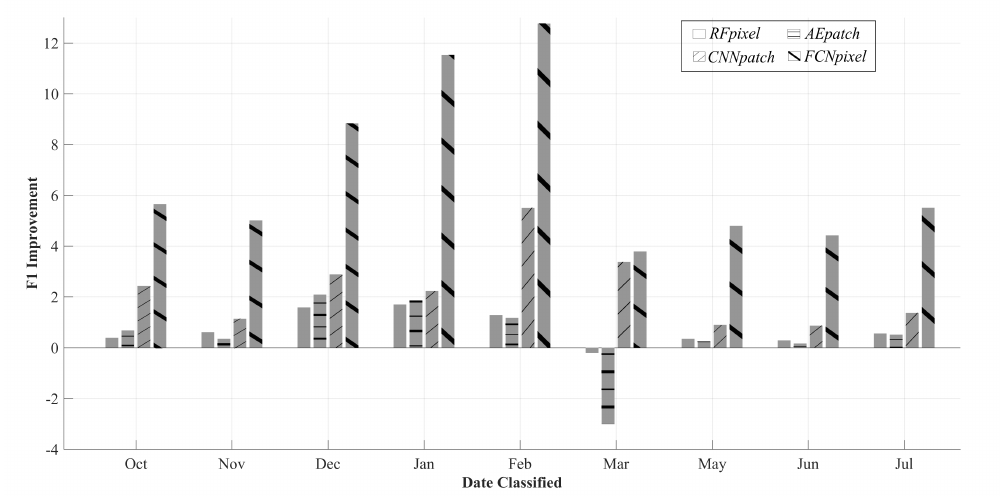
Figure 14. Average F1 score improvement for crops with more than 2% of the total samples of the dataset. From left to right in each bar-group RFpixel , AEpatch , CNNpatch and FCNpixel ,